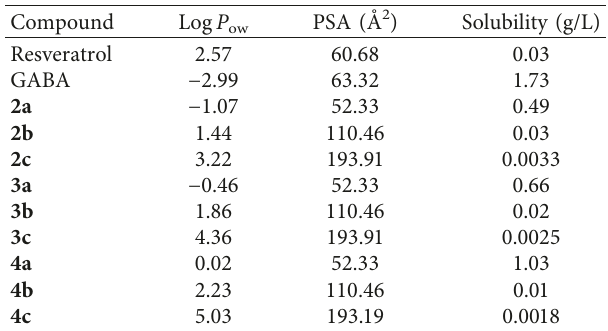
Table 1: Log P ow , water solubility, and topological PSA values of resveratrol and corresponding derivatives. Compound